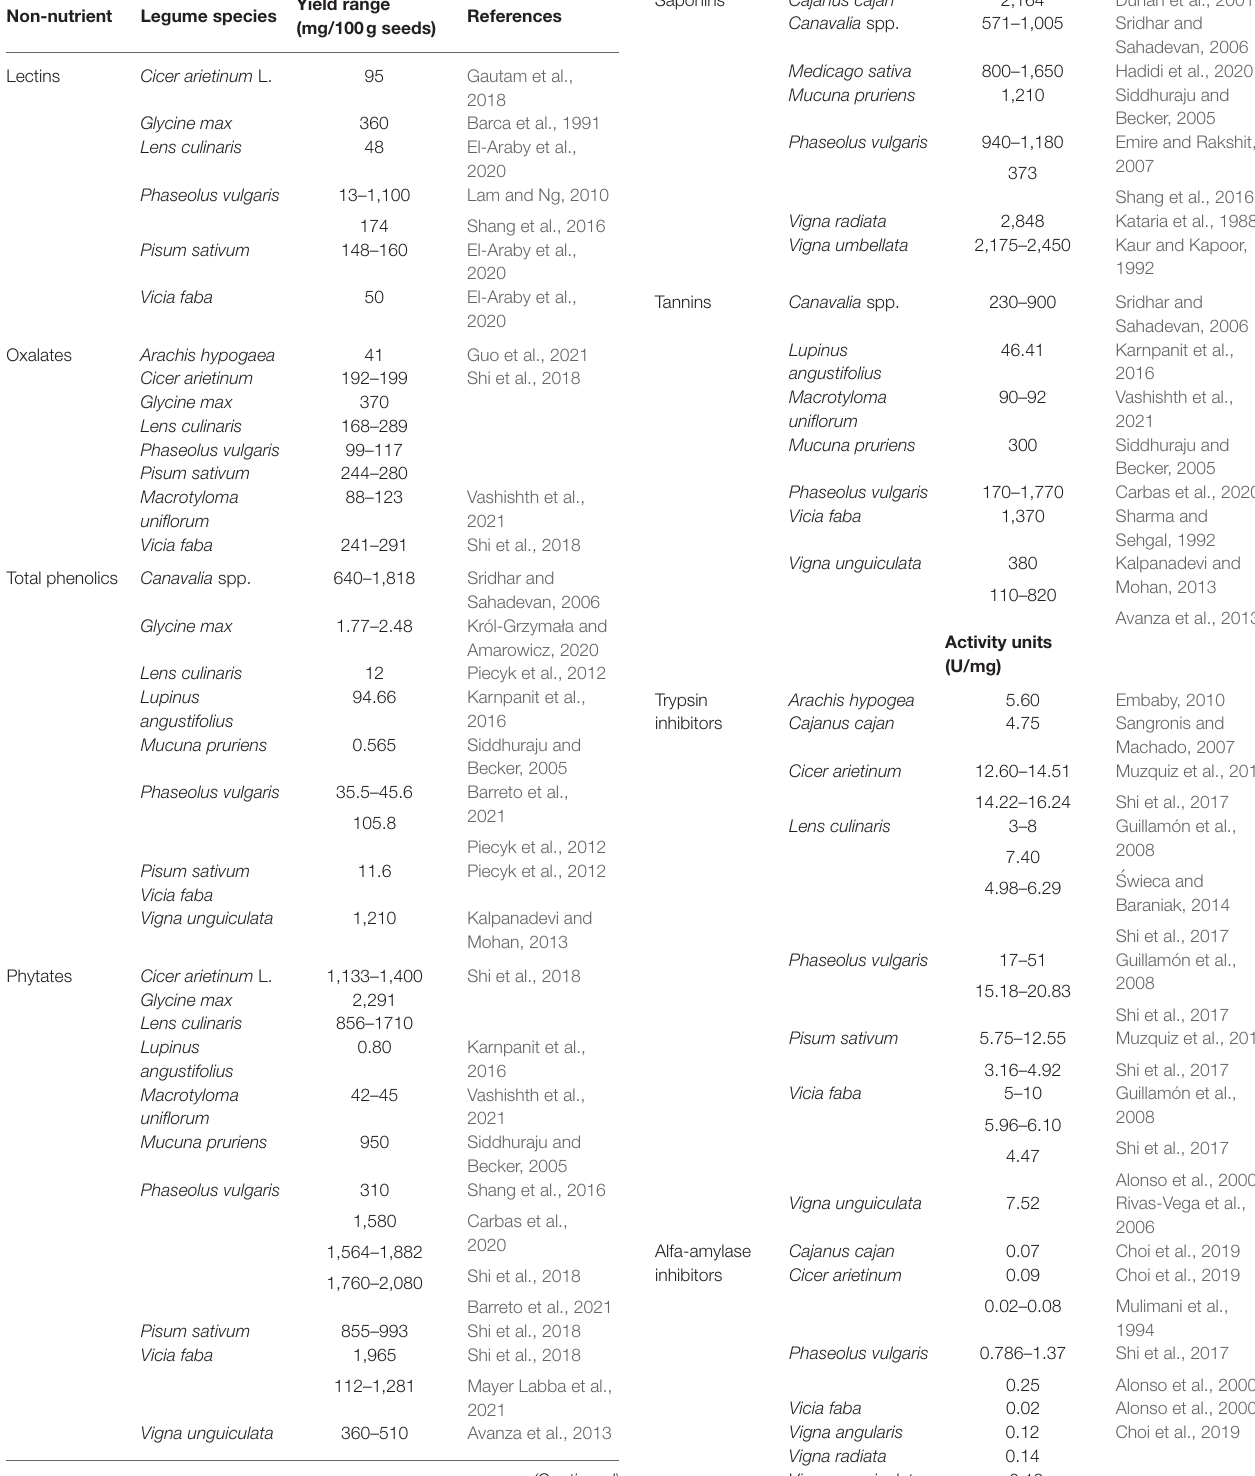
TABLE 1 | Summary of main legume species and concentrations of the non-nutrient’s lectins, oxalates, total phenolics, phytates, saponins, and tannins (in yield range), and of trypsin and alpha-amylase inhibitors (in activity units). Yield range Non-nutrient Legume species (mg/100 g